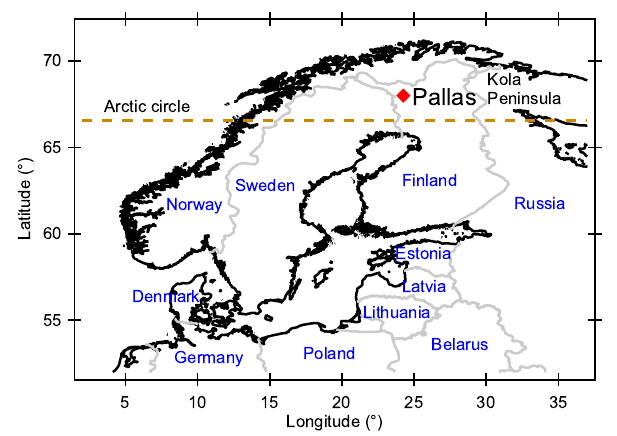
Figure 1. Location of the Pallas GAW